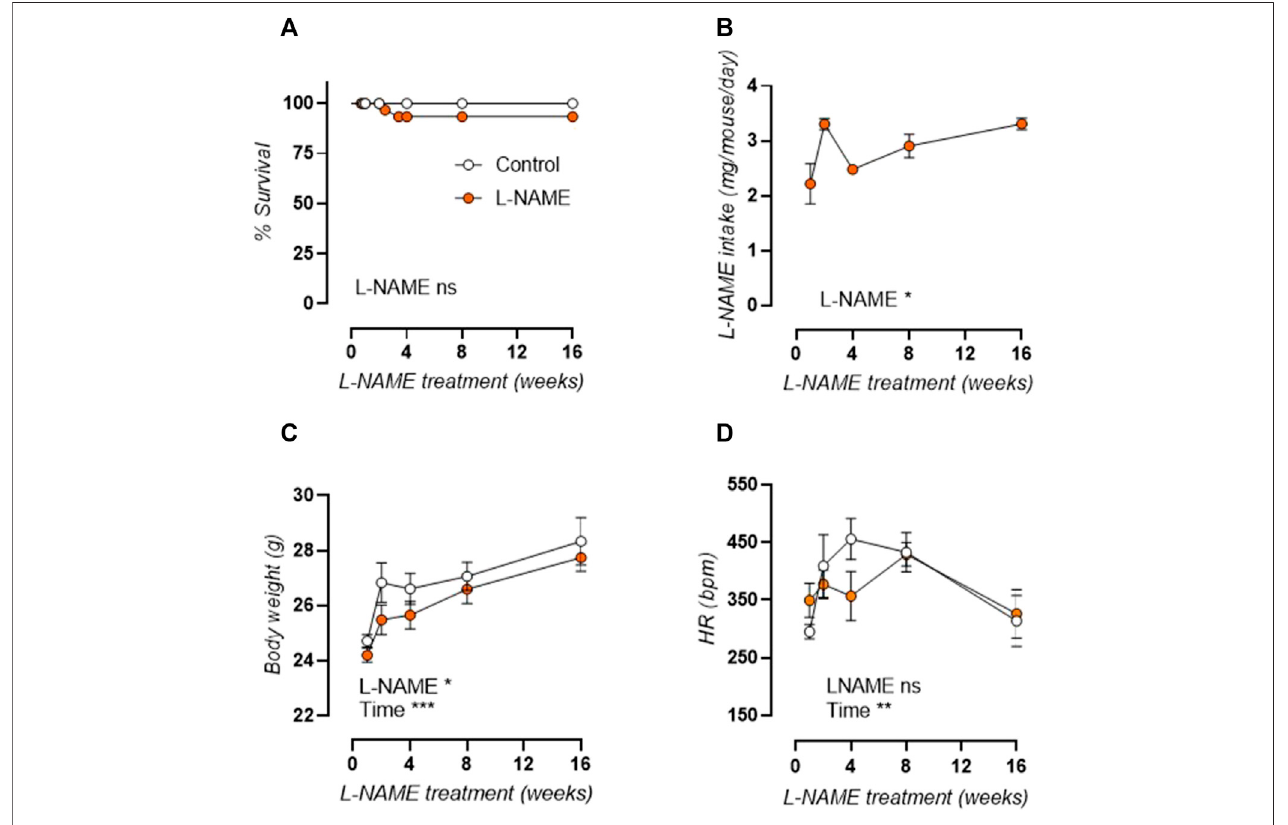
FIGURE1| OverallparametersoflongitudinalL-NAMEtreatedC57Bl/6mice.Survivalcurve (A) ,L-NAMEintake (B) ,bodyweight (C) ,andconsciousheartrate (D) are shown for L-NAME treated (n ≥ 7) and control (n ≥ 9) mice. Statistical analysis was performed by Mantel-Cox log-rank test (A) , one-way ANOVA (B) , or two-way ANOVA (C,D) . Overall signi fi cance is listed at the bottom of the graph. * p < 0.05, ** p < 0.01, *** p < 0.001.